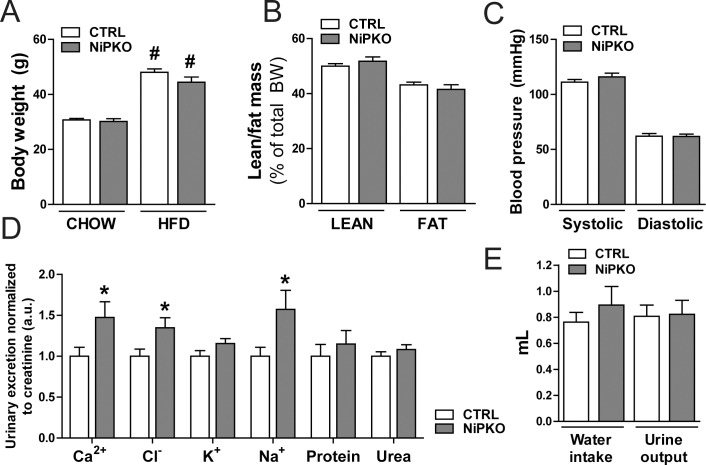
High fat diet-induced changes in control and NiPKO mice.Control (CTRL) and NiPKO mice were fed either a chow-diet (CHOW, 10 kcal% fat) or a high fat diet (HFD, 60 kcal% fat) for 5 months, starting at 2 weeks after DOX-administration. (A) Body weight at the end of chow or HFD feeding period (n = 10–15). (B) Body composition expressed as percentage lean and fat mass of total body weight of HFD-fed mice (n = 16). (C) Systolic and diastolic blood pressure measured via tail- cuff photoplethysmography of HFD-fed mice (n = 10). (D) Urinary levels of calcium (Ca2+), chloride (Cl-), potassium (K+), sodium (Na+), protein and urea over 16 hours, normalized to urinary excretion of creatinine, at the end of HFD feeding period (n = 9). (E) Water intake and urine output over 16 hours of HFD-fed mice (n = 15–16). Error bars represent mean ±SEM. Significant differences (p-value <0.05) between genotypes are indicated by an asterisk (*) and between chow- and HFD-fed groups by a number sign (#).